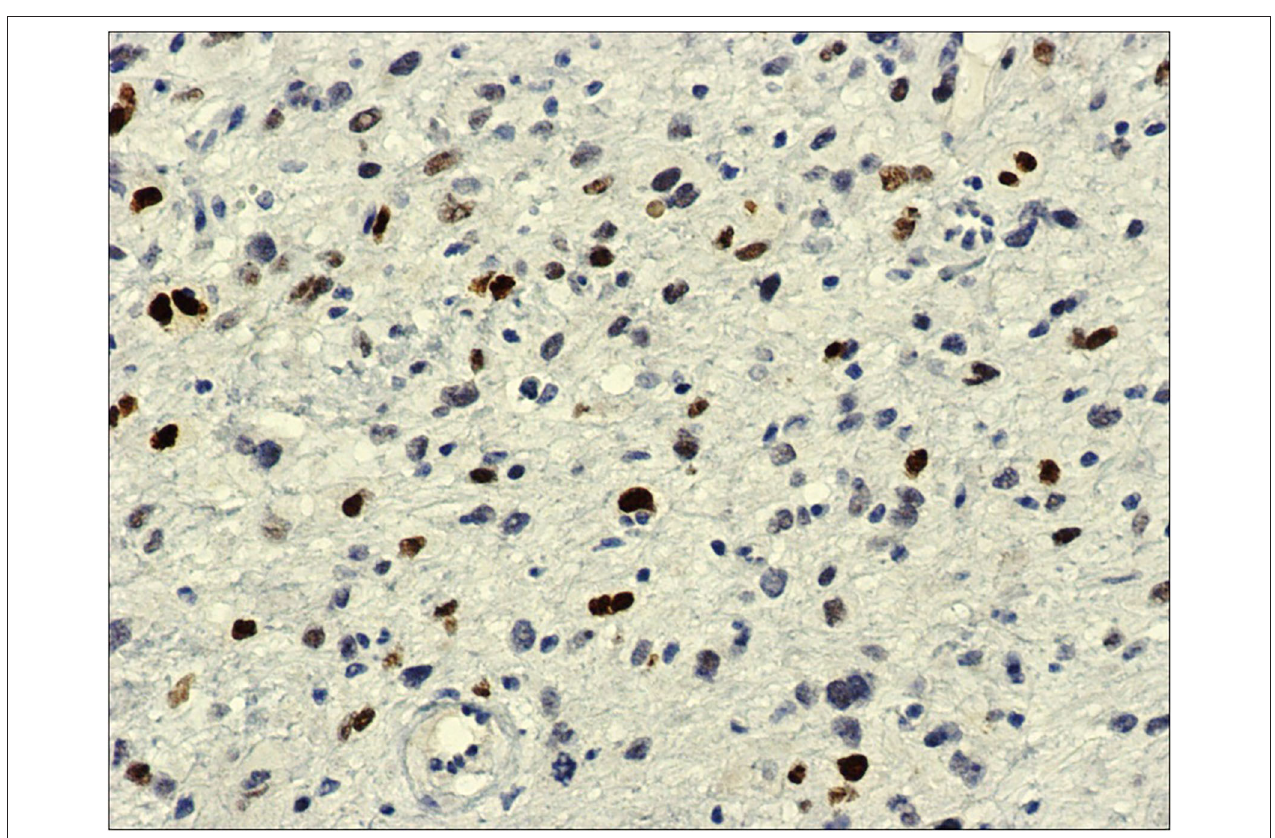
FIGURE 4 | MDM2, 20x: immunohistochemistry against MDM2-antibody shows diffuse and intense nuclear